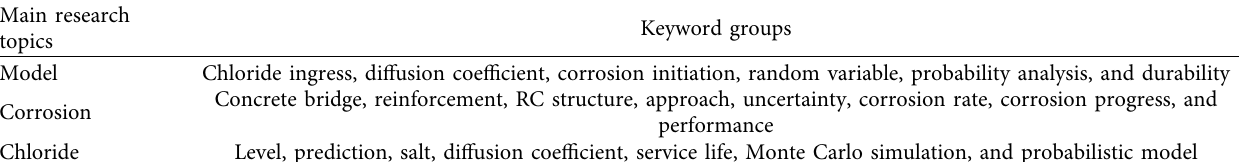
Table 6: Main keywords and corresponding keyword group.